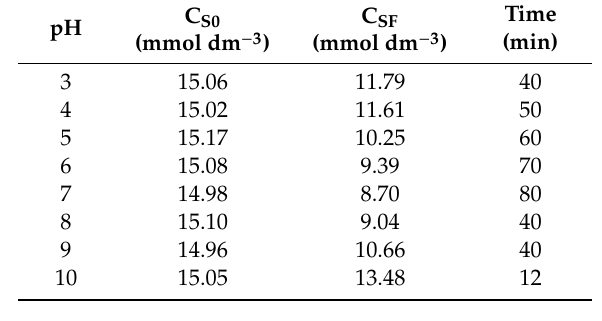
Figure 1. Change in H 2 O 2 concentration during the decomposition reaction catalyzed using bovine liver catalase. ( a ) pH 3–7, ( b ) pH 7–10. Experiments were carried out at 25 ◦ C. Readings were taken at 2-s intervals during 20 min. Afterwards, readings were taken every 10 min until a constant C SF concentration was reached. Table 1. Initial (C S0 ) and final (C SF ) concentration of hydrogen peroxide at different pH.